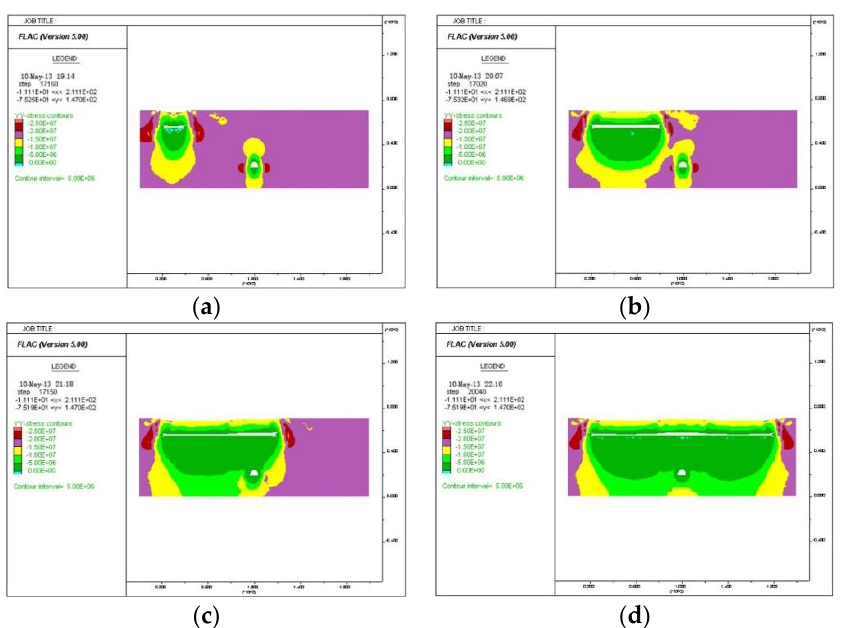
Figure 14. Horizontal stress distribution of surrounding rock of roadway supported by bolt and shed. ( a ) Working face is 60 m away from the roadway. ( b ) Working face is 20 m away from the roadway. ( c ) Working face spans the roadway 20 m. ( d ) Working face spans the roadway 60 m.